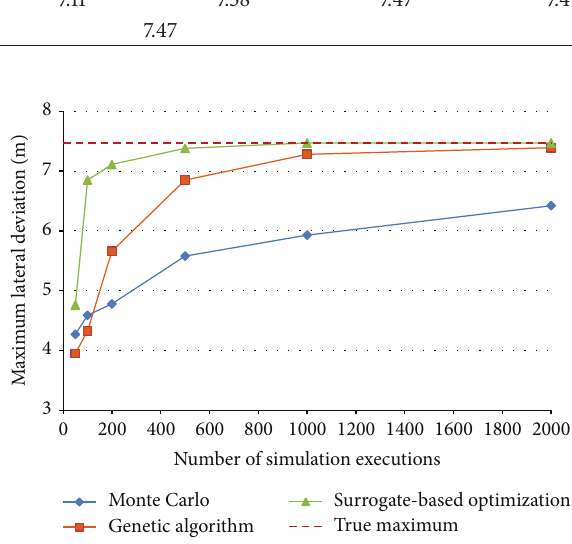
Figure 11: Maximum lateral deviation as a function of allowable simulation